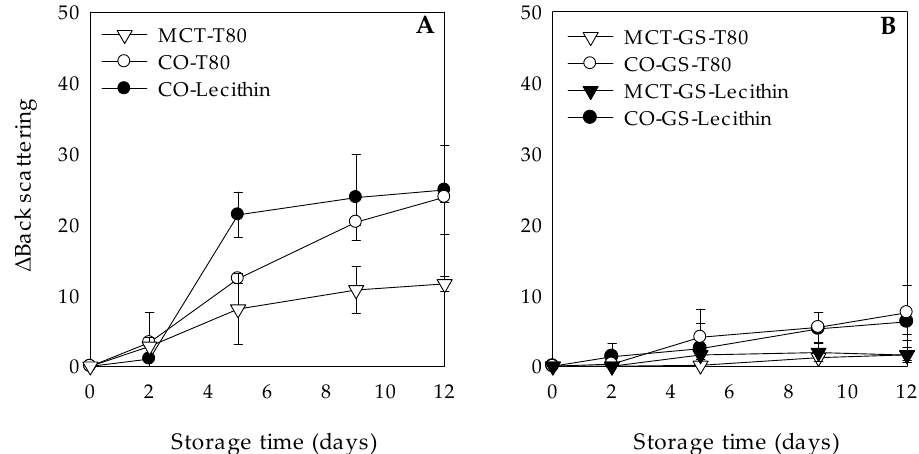
Figure 2. Clarification, expressed as variation of back scattering ( ∆ BS), at 4 ◦ C during 12 days of dark storage of chlorophyllin-loaded W 1 /O/W 2 emulsions formulated with different lipid phases consisting on medium chain triglyceride (MCT) or corn oil (CO) and without ( A ) or with ( B ) glyceryl stearate (GS) as well as different hydrophilic surfactants (Tween 80 (T80) or